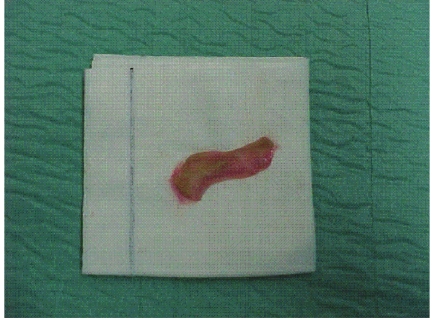
Figure 2: Foreskin trimmed in a rectangular shape. Figure 3: Residual open area after excision of the nevus (a) and foreskin graft sutured to cover the cutaneous defect (b).